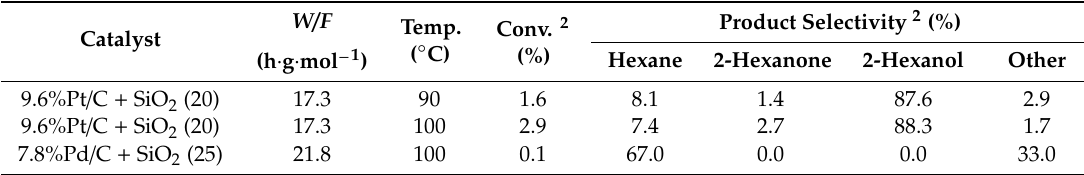
Table 4. Hydrogenolysis of DMTHF 1